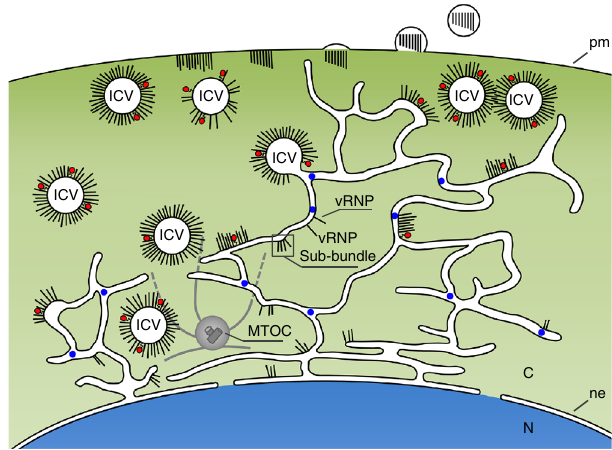
Fig. 10 Model for the traf fi cking of vRNPs across the cytoplasm in an IAV- infected cell. The remodeled tubulo-vesicular ER, positive for the PDI marker (in blue) extends around the MTOC (in gray) and from the nuclear envelope (ne) to the plasma membrane (pm). After their exit from the nucleus, individual vRNPs and/or sub-bundles of vRNPs are targeted to the modi fi ed ER. ICVs loaded with vRNPs and with the Rab11 molecule (in red) might bud from the ER and ensure the transport of vRNPs to the plasma membrane. The frequently observed pairing of ICVs could favor RNA − RNA interactions among vRNPs and the progressive assembly of sets of 8 distinct vRNPs. vRNPs are released from ICVs and possibly transferred to the plasma membrane in a touch-and-go